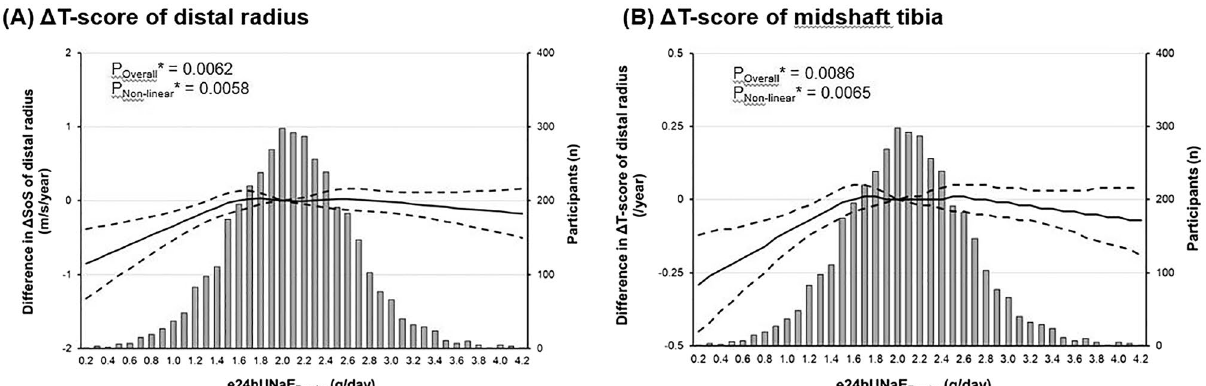
Figure 1. Non-linear relation of e24UNaE Tanaka with the change of ( A ) ΔT-score of distal radius and ( B ) ΔT-score of midshaft tibia compared with the chosen reference e24UNaE Tanaka of 2.0 g/day. Solid line represents the change of bone marrow densitometry indicators and dash lines 95% confidential intervals. *Calculated by restricted cubic spline regression using age, sex, and smoking history as